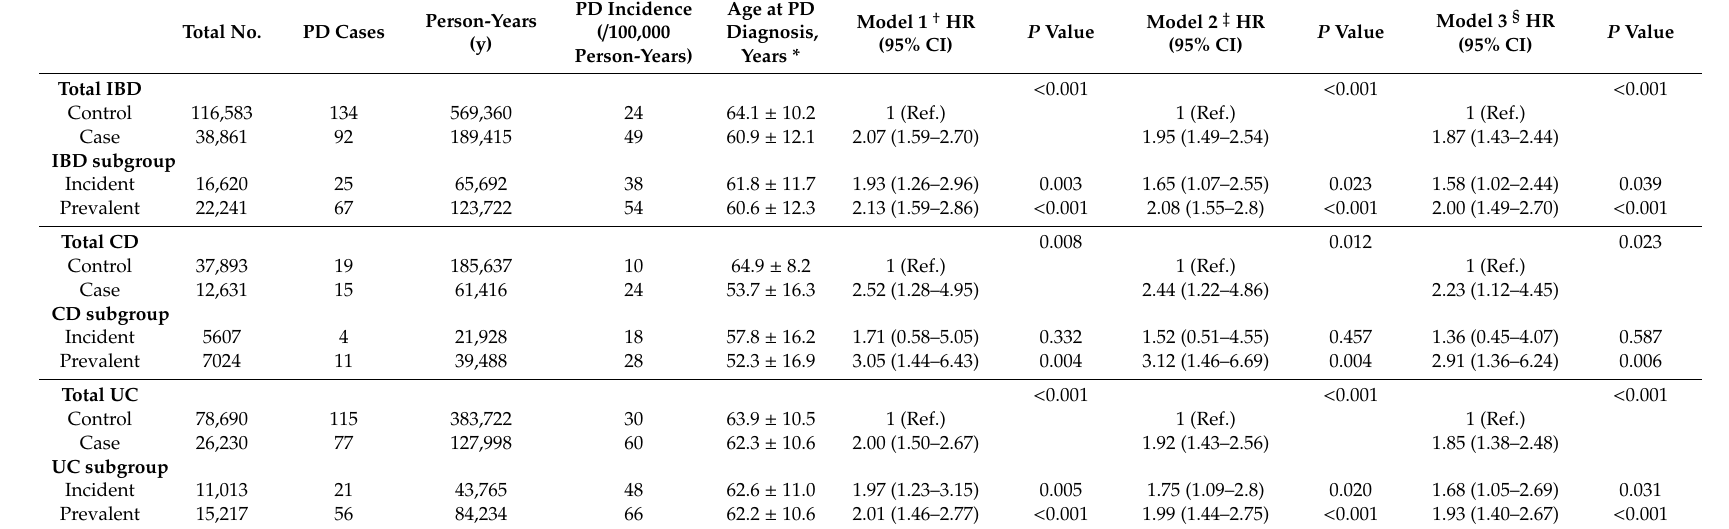
Table 2. Incidence and risk of Parkinson’s disease in patients with inflammatory bowel